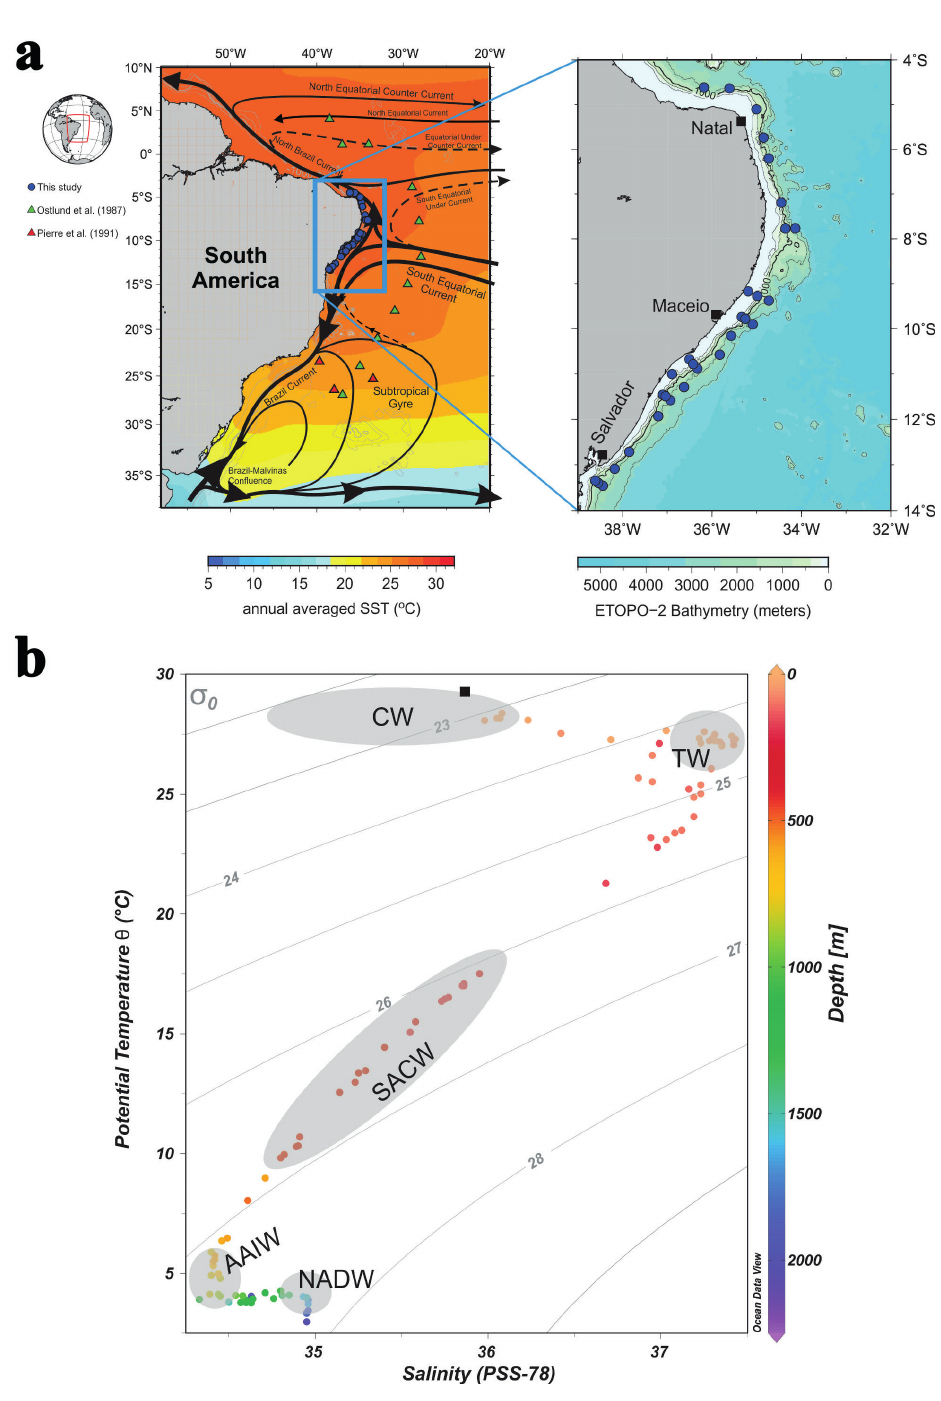
Figure 1 - ( a ) the geographical distribution of the seawater samples. the blue dots correspond to the present dataset. the red and green triangles represent the Pierre et al. (1991) and Ostlund et al. (1987) data, respectively. ( b ) t-S diagram showing the distribution of water masses and individual samples in this